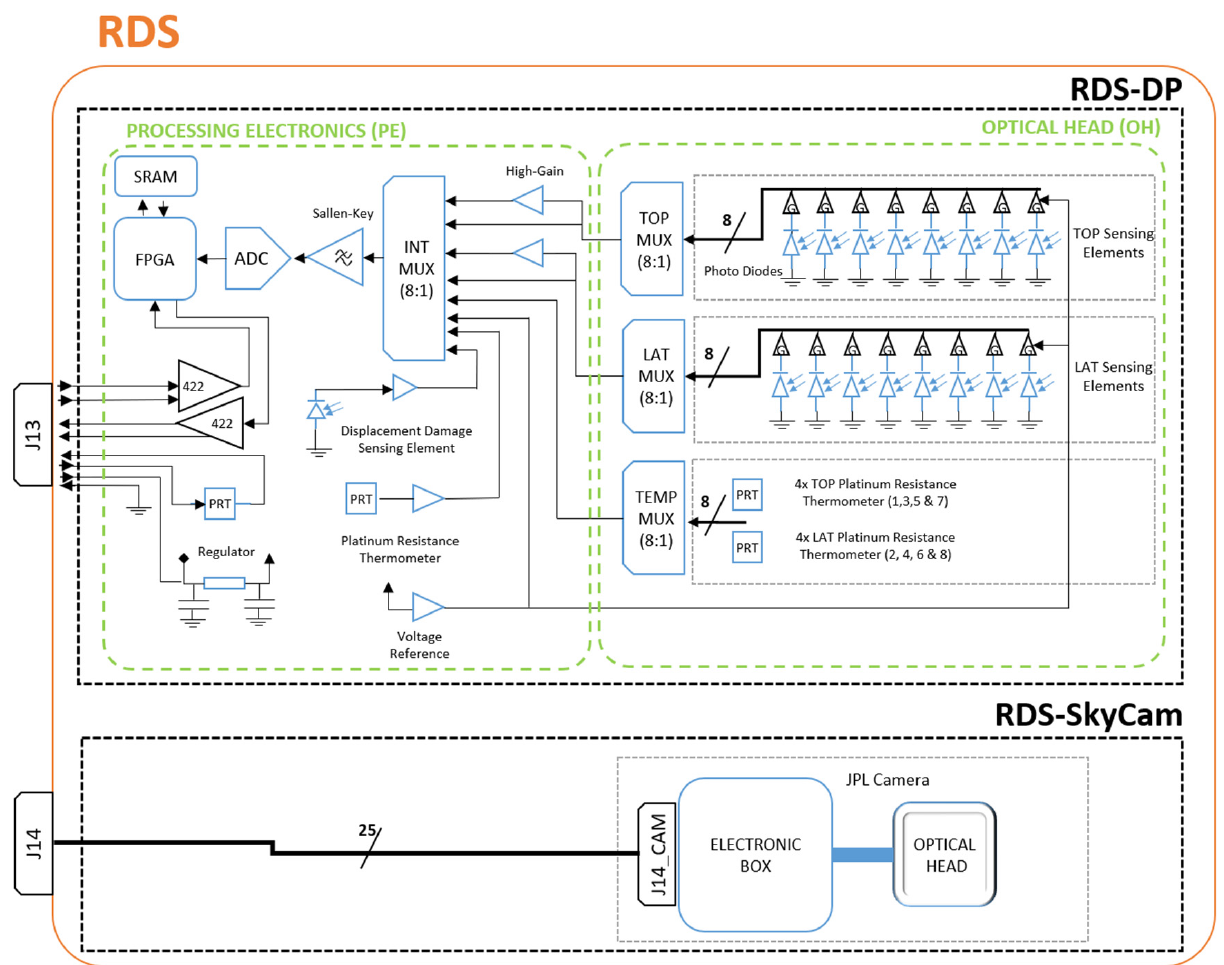
Figure 7. RDS, electrical, and electronics scheme.